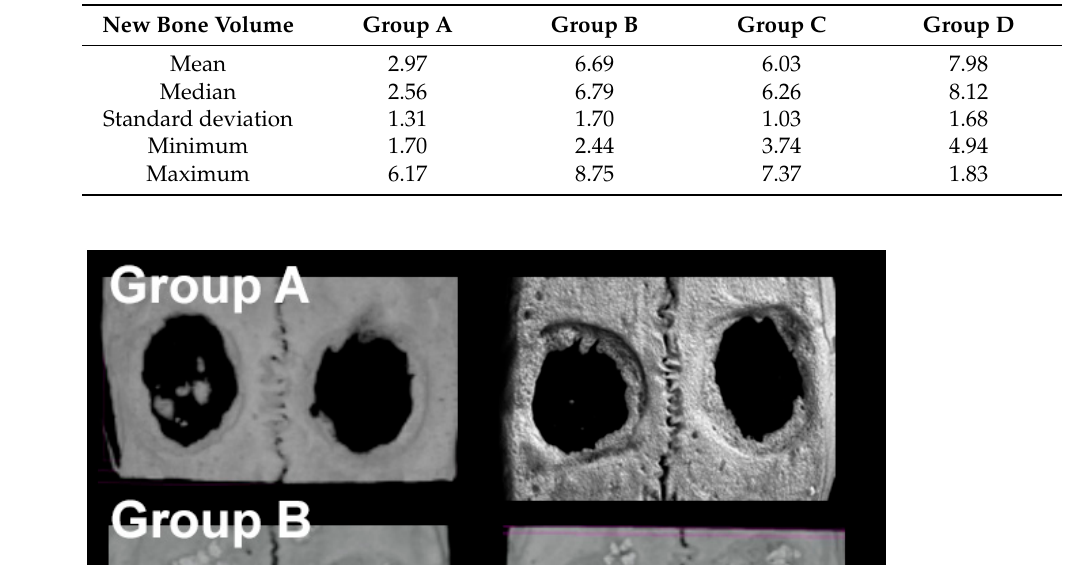
Table 1. Descriptive statistics for the newly formed bone volume (mm 3 ).